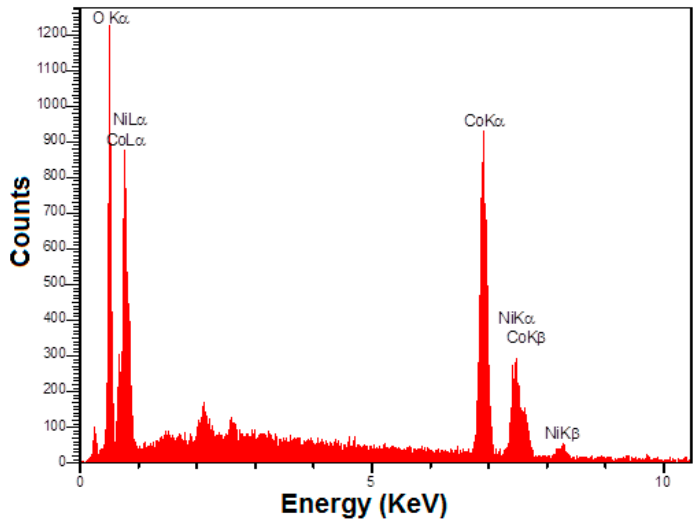
Figure 2. EDS spectrum of hierarchical flower-like NiCo 2 O 4 nanoplates.